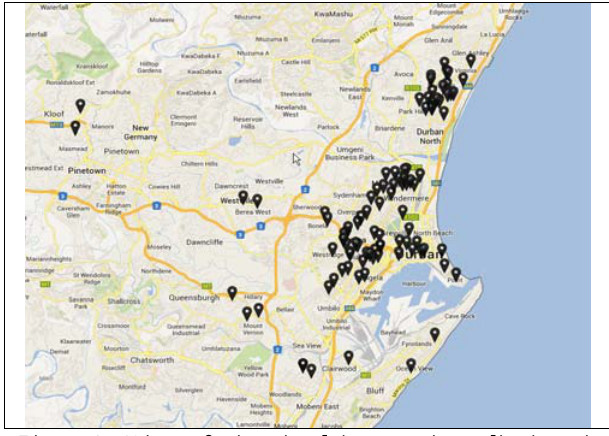
Figure 3. View of sites involving permit applications in KwaZulu-Natal.